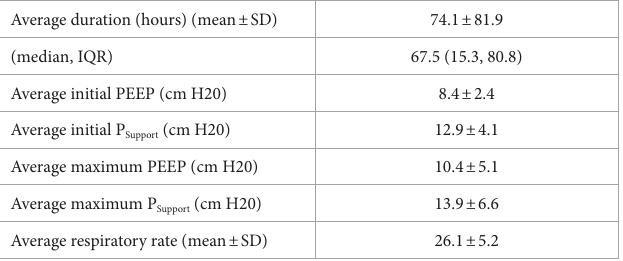
Table 4 outlines patient outcomes. Of those treated with helmet, 10/16 (62.5%) patients were ultimately intubated. The primary reason for intubation was hypoxia (70%). In those that required intubation, patients received helmet NIV for a median (IQR) of 42.0 (5.5, 72.0) hours before intubation. Three (18.7%) patients did not tolerate helmet NIV due to increased agitation and were switched to facemask NIV ( n = 2) or HFNC ( n = 1). All 3 of these patients had COVID ARDS and